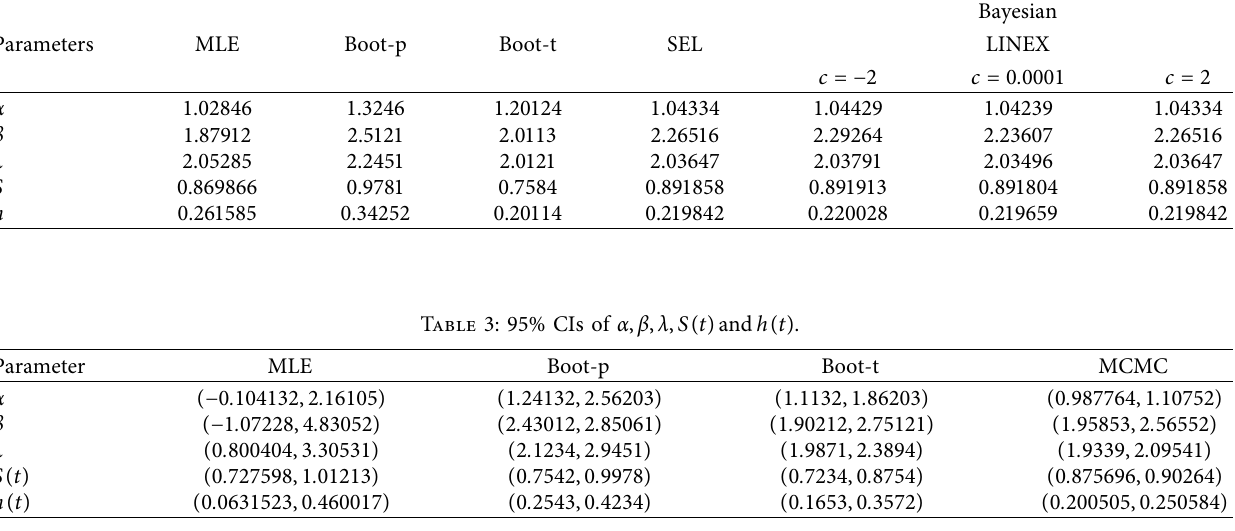
Table 4: MSE of ML and Bayesian estimates for the parameter α with α